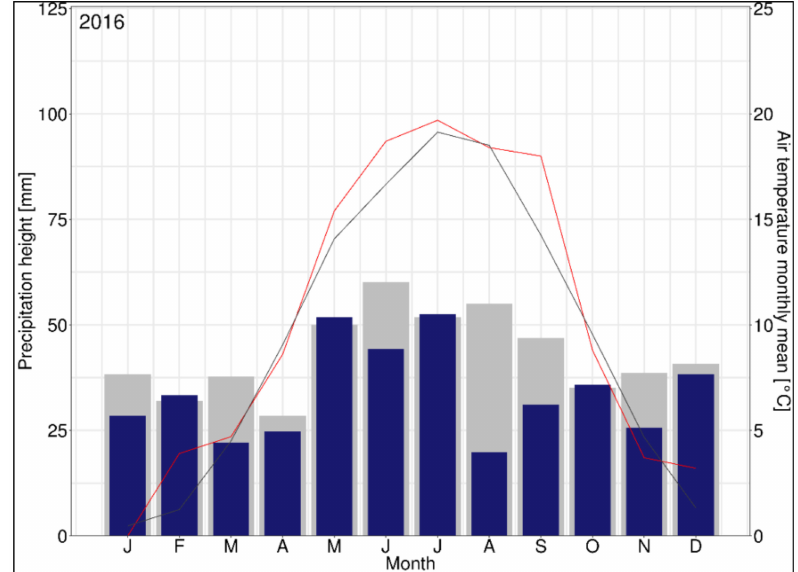
Figure 1. Precipitation heights (blue bars) and medium monthly air temperature (red line) of 2016 on the experimental site. Gray bars and the black line show the medium long-term values